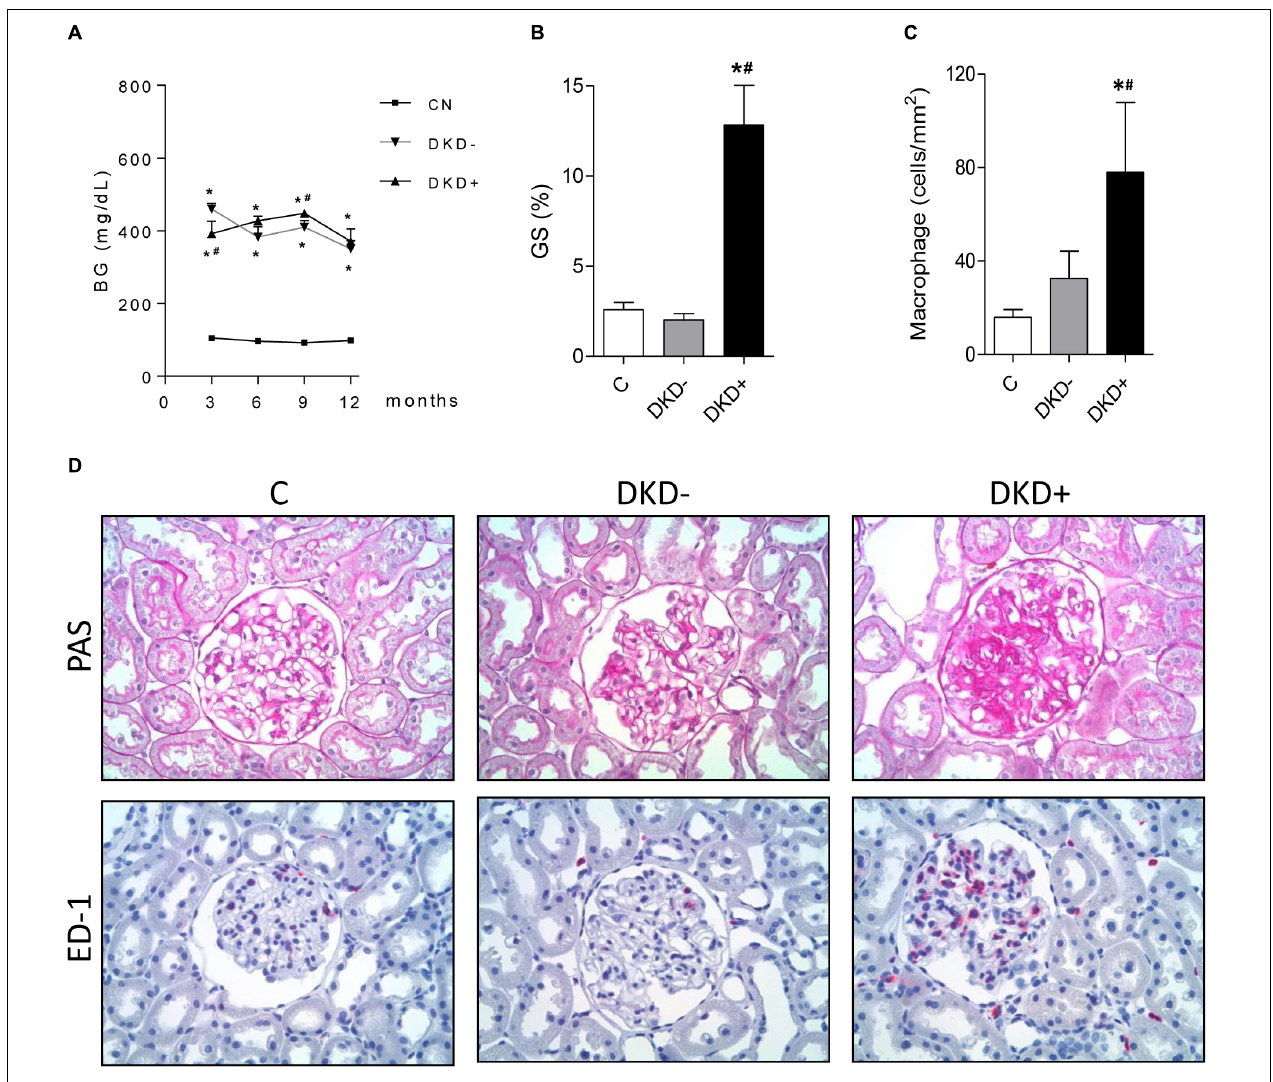
FIGURE 2 | Twelve months after STZ injection, the 10 DM rats with the highest values for percent glomerulosclerosis (%GS) were used to create the DKD+ group, whereas the 10 DM rats with the lowest %GS values constituted the DKD– group. Twelve non-diabetic age-matched rats were taken as controls (C). The time course of blood glucose concentration (BG, mg/dL) is shown in panel (A) , whereas the %GS and glomerular macrophage density (ED-1, cells/mm 2 ) at 12 months of DM appear at panels (B,C) , respectively. Representative microphotographs of renal tissue stained with PAS (for %GS) or immunohistochemistry (for macrophage-specific ED-1 antigen) are shown in panel (D) (x400). Results expressed as means ± SE. * p < 0.05 vs. C, # p < 0.05 vs.